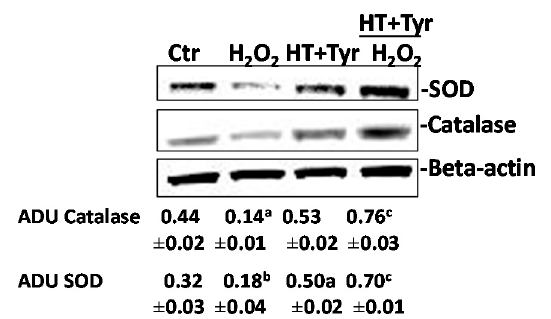
Figure 4. Combination of polyphenols rescues superoxide dismutase (SOD) and catalase expression in HUVEC exposed to H 2 O 2 . Western blot analysis of SOD and catalase in HUVEC exposed to H 2 O 2 (100 µ M) with/without HT + Tyr (10 µ M each). Beta-actin is used for normalization. Expression of catalase or SOD is reported as arbitrary density unit (ADU). a p < 0.05, b p < 0.01 vs. 1% Ctr = FCS; c p < 0.01 versus H 2 O 2 . The gels are representative of three runs with similar results.